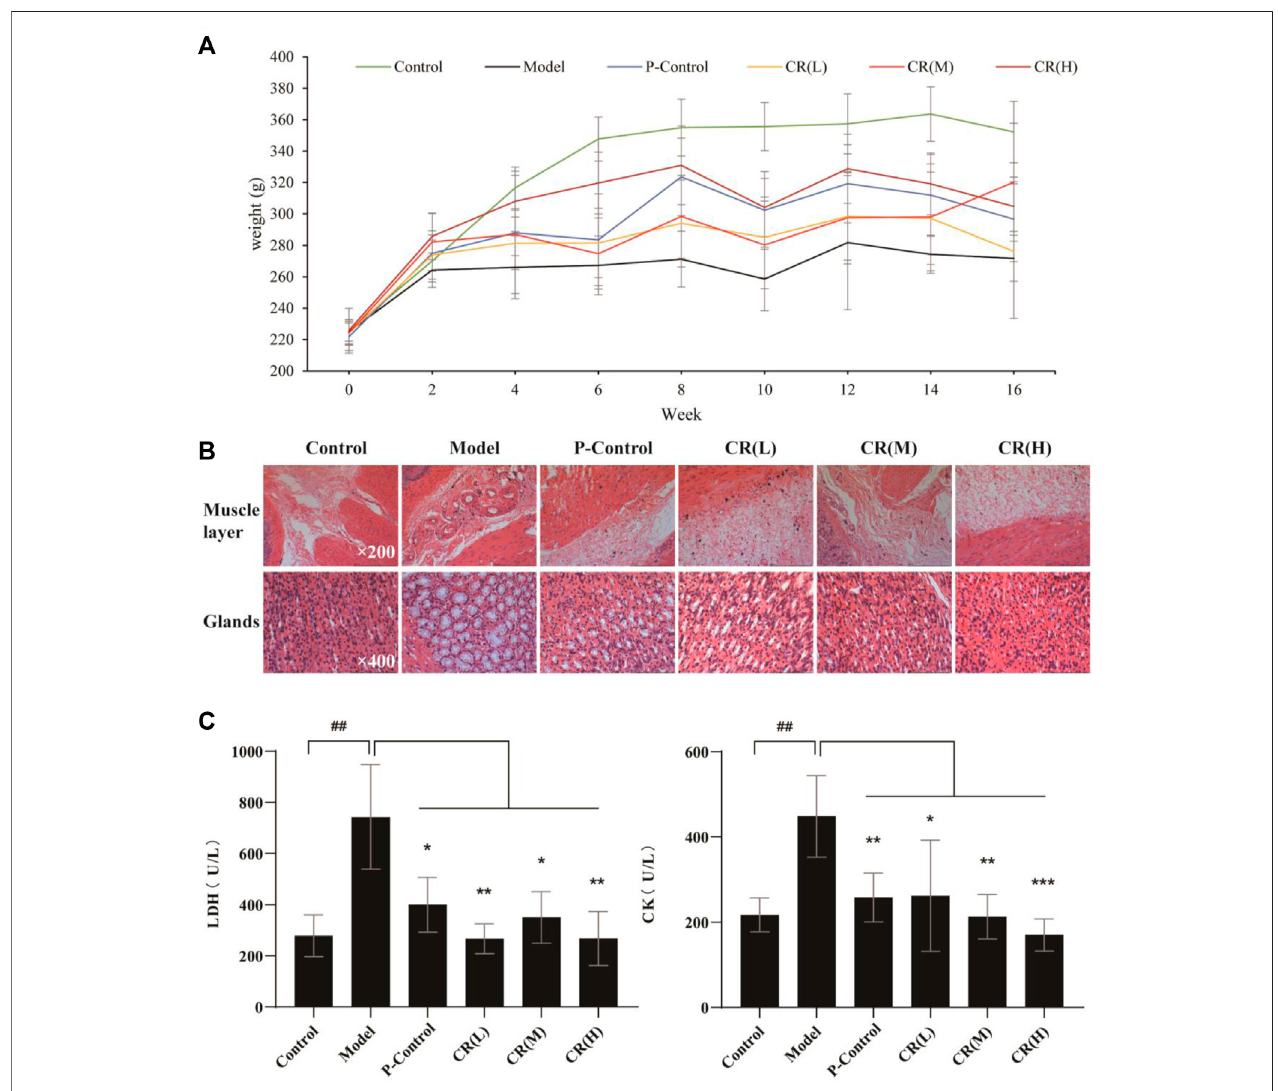
FIGURE1| ThepharmacodynamicresultsofCRinthetreatmentofGPLrats. (A) Weightdiversitycurveofanimalexperiments. (B) HEstainedpathologicalsection ofgastric tissue indifferentgroup. (C) ThecontentsofLDH(LactateDehydrogenase)and CK(Creatine Kinase)inserum ofdifferentgroup. Thegraphsshow themean± SD of at fi ve independent experiments ( n = 5). ## p < 0.01 vs Control. * p < 0.05, ** p < 0.01 and *** p < 0.001 vs. Model.